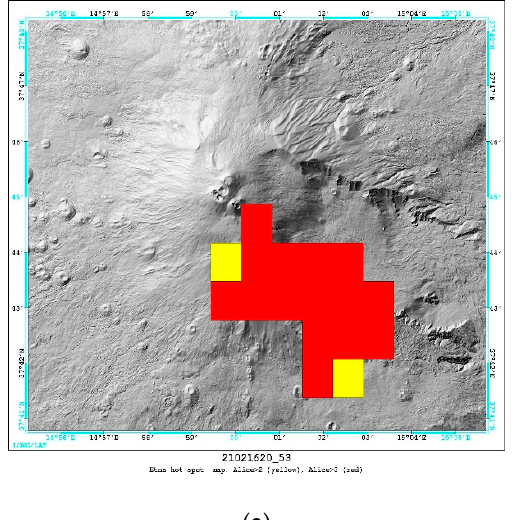
Figure 7. Temporal trend of VRP retrieved from SEVIRI (in black) data (at 15 min time interval) starting from RST VOLC detections with the indication of the number of the Mt. Etna paroxysms. Paroxysms’ time duration (light pink bars) and cloudiness percentage (light grey line) are repre- sented as well. The figure shows that, after the identification of a subtle thermal anomaly ( ≈ 30 MW) in the morning of 16 February (i.e., at 08:30 UTC), a first increment of the thermal vol- canic activity occurred at 16:00 UTC (VRP ≈ 280 MW). One hour later, the radiative power abruptly increased up to about 3.5 GW, marking the start of the lava overflow. At 17:45 UTC, the peak of radiative power was recorded, around 4.2 GW. Lower values of 1 st 2 nd 3 rd 4 th 5 th 6 th